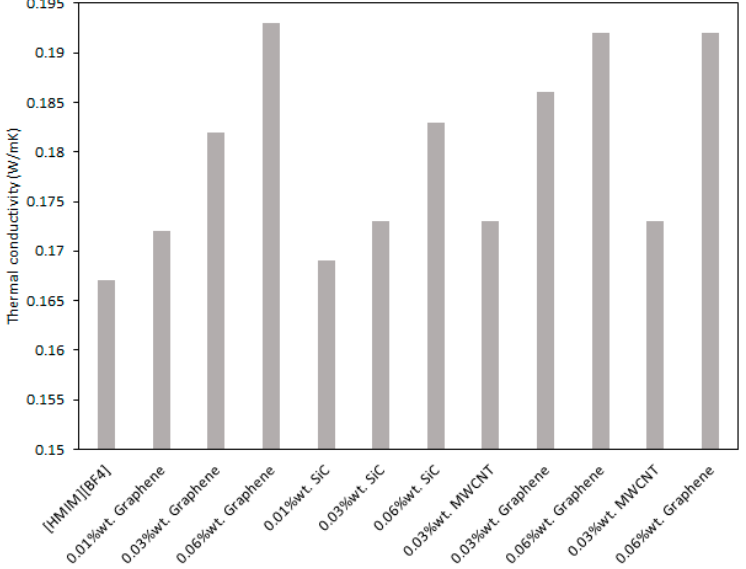
Figure 6. Influence of the nanoparticle type on thermal conductivity of ILs.